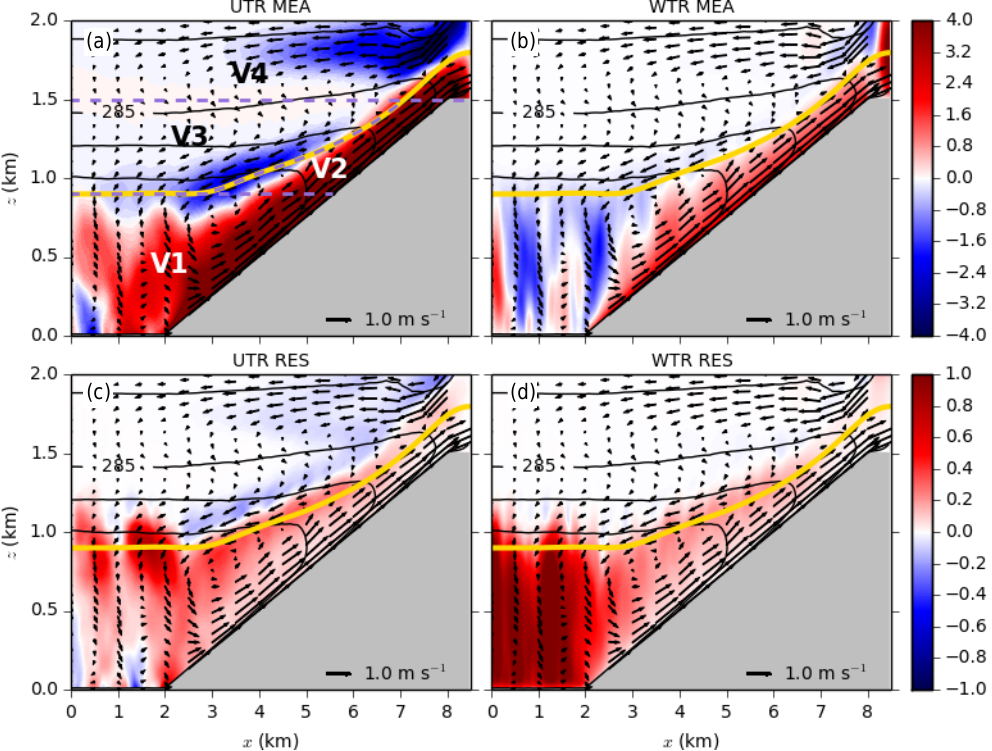
Figure 3. Horizontal and vertical tracer mass fluxes for simulation S1N10 at 12:00LT. Shown are (a) cross-valley mean (UTR MEA), (b) vertical mean (WTR MEA), (c) cross-valley turbulent resolved (UTR RES), and (d) vertical turbulent resolved (WTR RES) tracer mass fluxes as colour contours. All fluxes are normalized by the tracer mass flux at the surface and are therefore dimensionless. The colour bars to the right apply to each row. Notice that the colour scale in (c, d) is smaller by a factor of 4 than in (a, b) . Potential temperature, wind vectors and the boundary/slope wind layer height according to the heat-flux criterion are as in Fig. 2. The volumes V1 to V4 are also shown in (a) . The purple dashed lines denote the boundaries between these